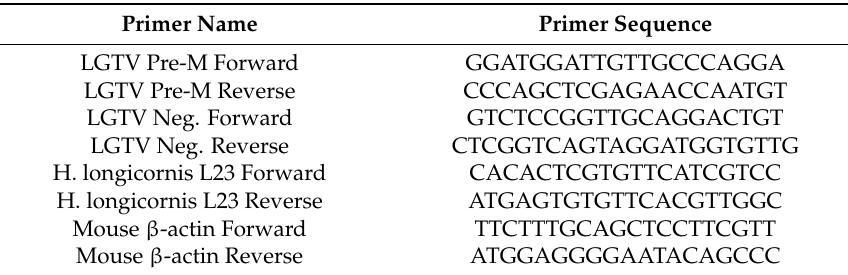
Table 1. List of real-time PCR primers used to detect Langat Virus